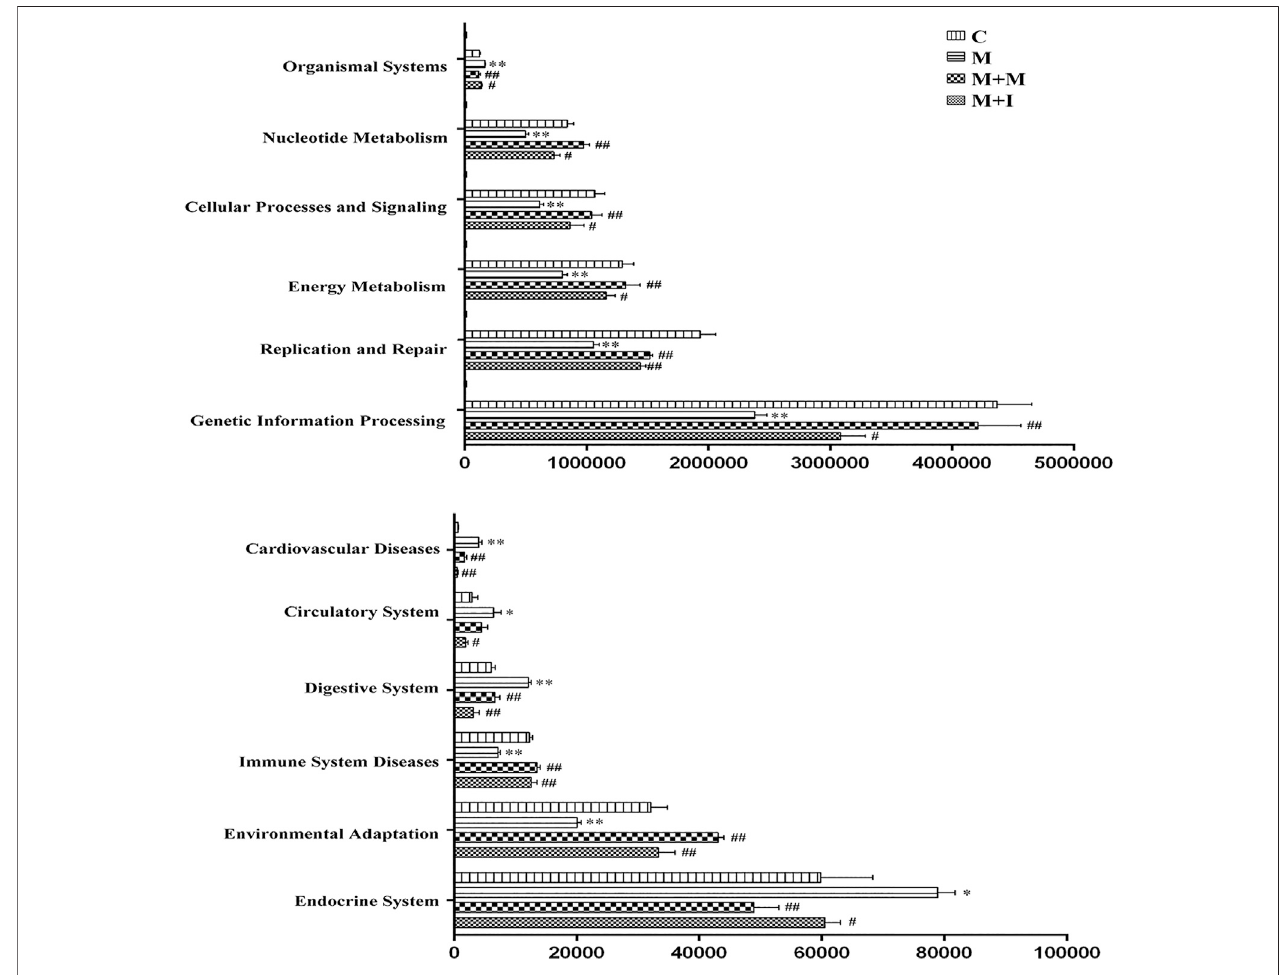
FIGURE 7 | Differentially regulated functional pathways based on KEGG enrichment analysis inferred from 16S rRNA gene sequences using PICRUSt. * p < 0.05, ** p < 0.01 vs the control (C) group; # p < 0.05, ## p < 0.01 vs the M group.